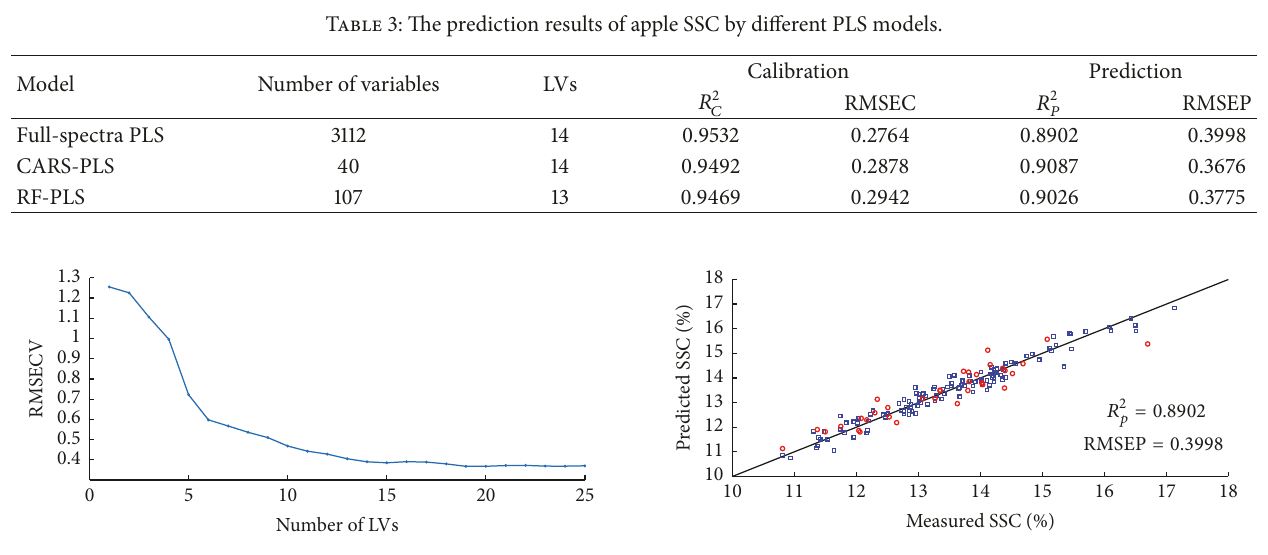
Figure 6: Variation of RMSECV in PLS model with the number of LVs increasing.